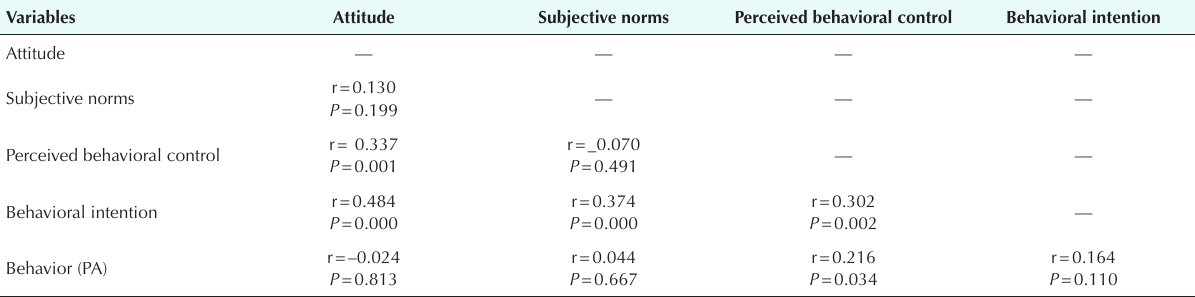
Table 3 . The coefficients of the pairwise correlations of the study variables Variables Attitude Subjective norms Perceived behavioral control Behavioral intention Attitude — — — — r = 0.130 Subjective norms — — P = 0.199 Perceived behavioral control Behavioral intention Behavior